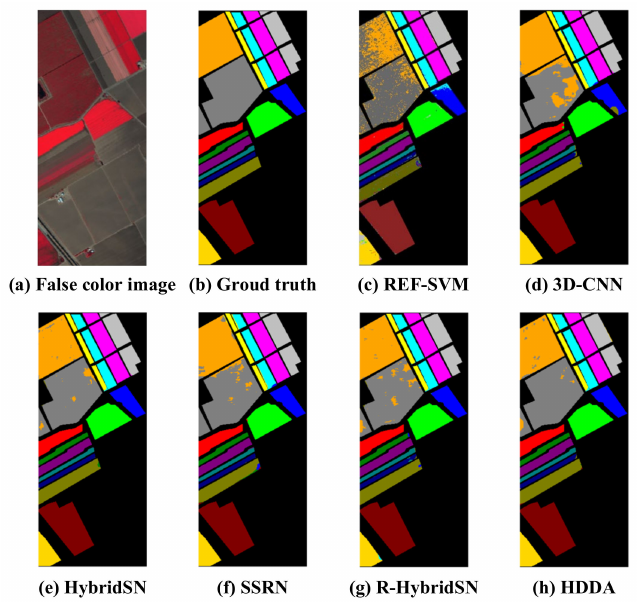
Figure 14. Classification maps using only the training samples (1% of total samples) for the SA dataset. ( a ) False color image; ( b ) Ground truth; ( c ) REF-SVM; ( d ) 3D-CNN; ( e ) HybridSN; ( f ) SSRN; ( g ) R-HybridSN; ( h ) HDDA.